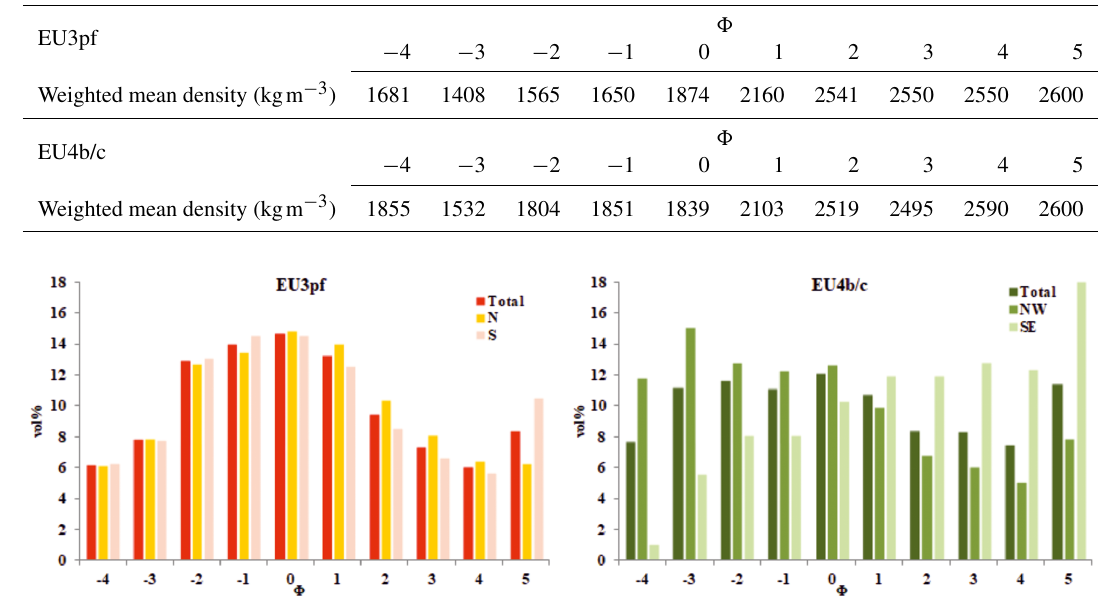
Figure 4. Volumetric total grain size distributions for the EU3pf and EU4b/c units.